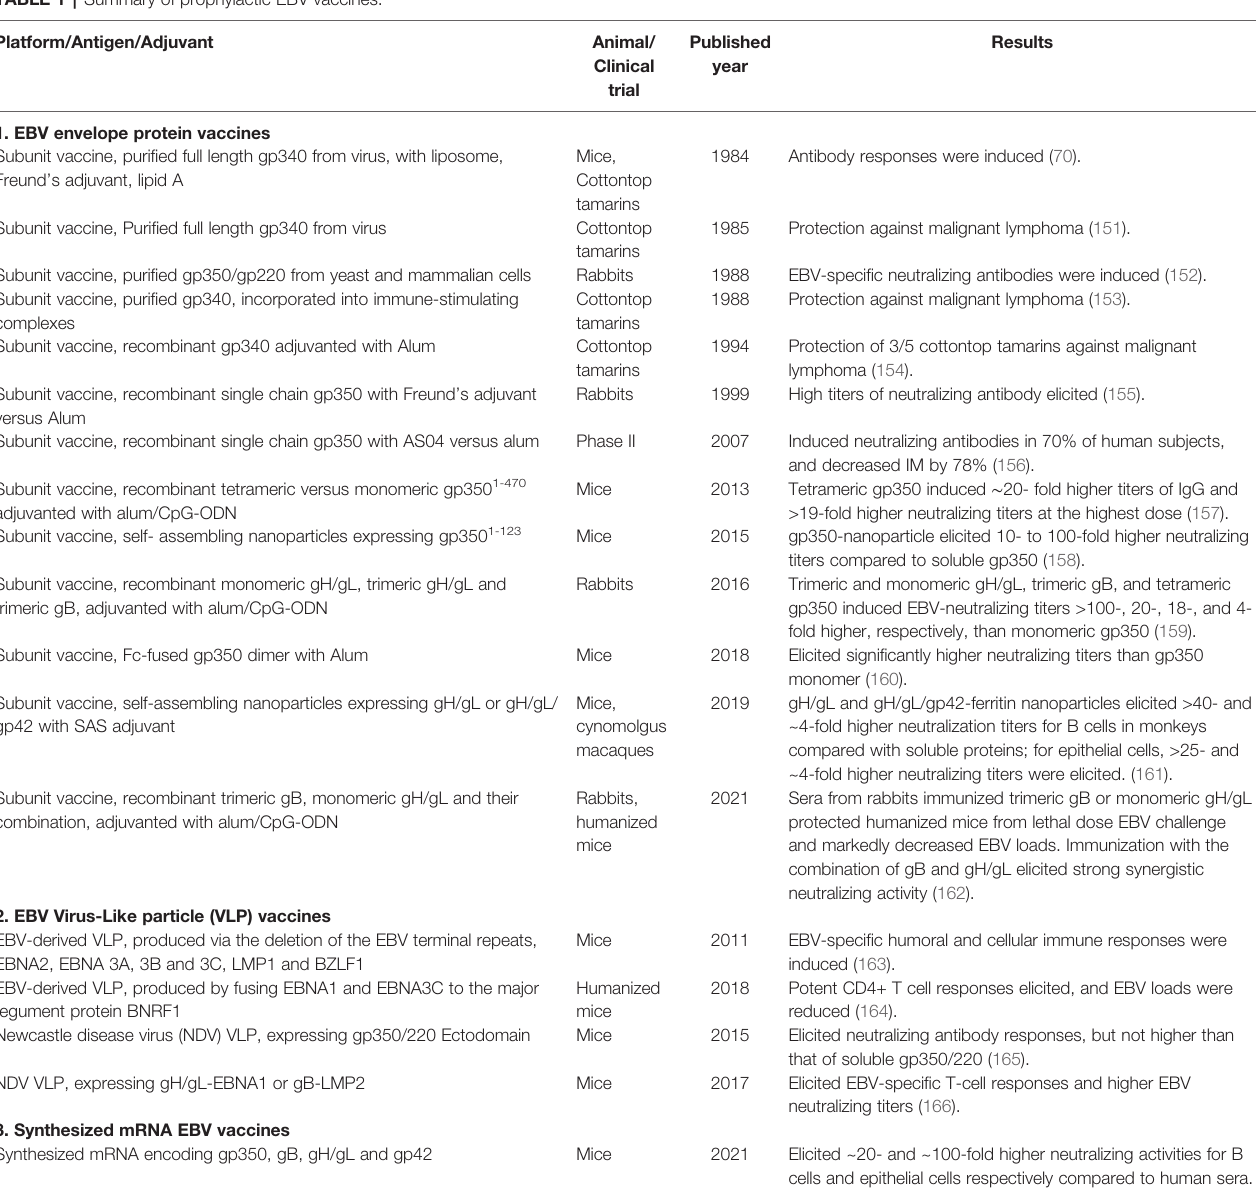
TABLE 1 | Summary of prophylactic EBV